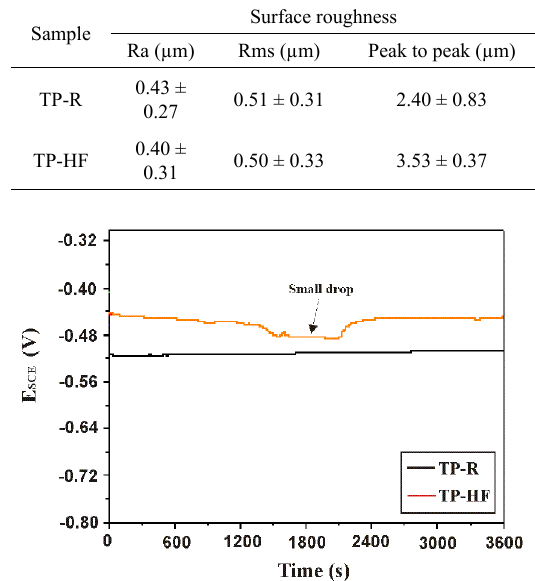
shifted toward positive values compared with the